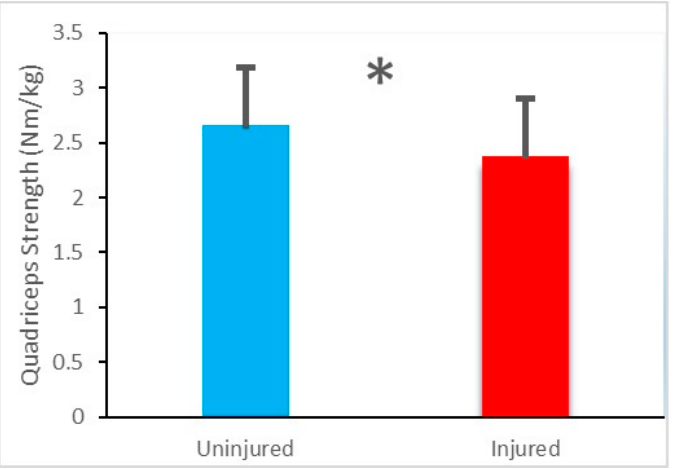
Figure 1. Mean and standard deviation values of quadriceps strength of the injured limb and uninjured limb. * Denotes a significant